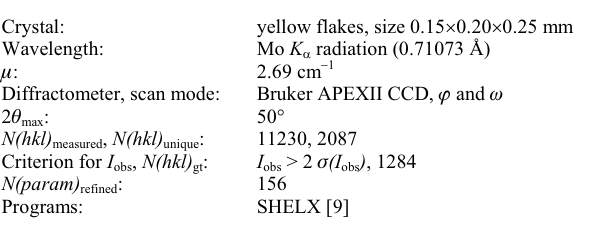
Table 1. Data collection and handling.